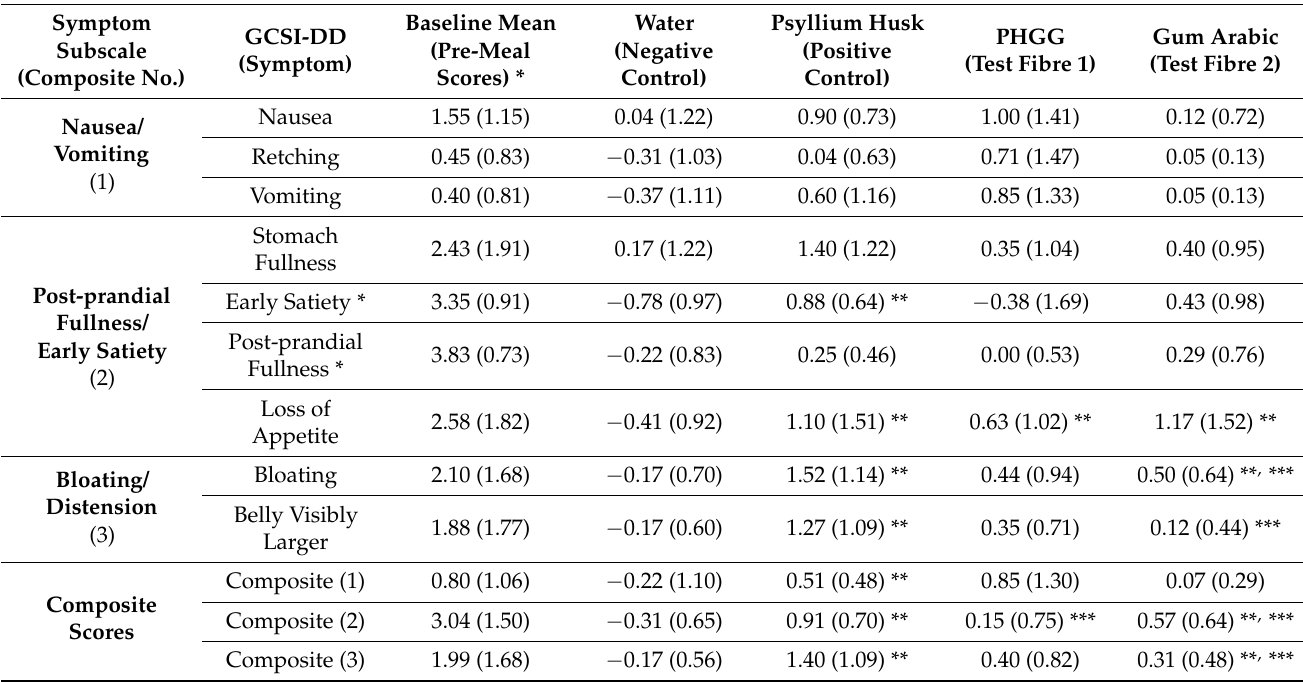
Table 3. Mean normalized ANMS GCSI-DD scores across all time-points for n = 10 participants in the study, with Composite (1) score for (Nausea/Vomiting); Composite (2) score for (Post-prandial Fullness/Early Satiety) and Composite (3) score for